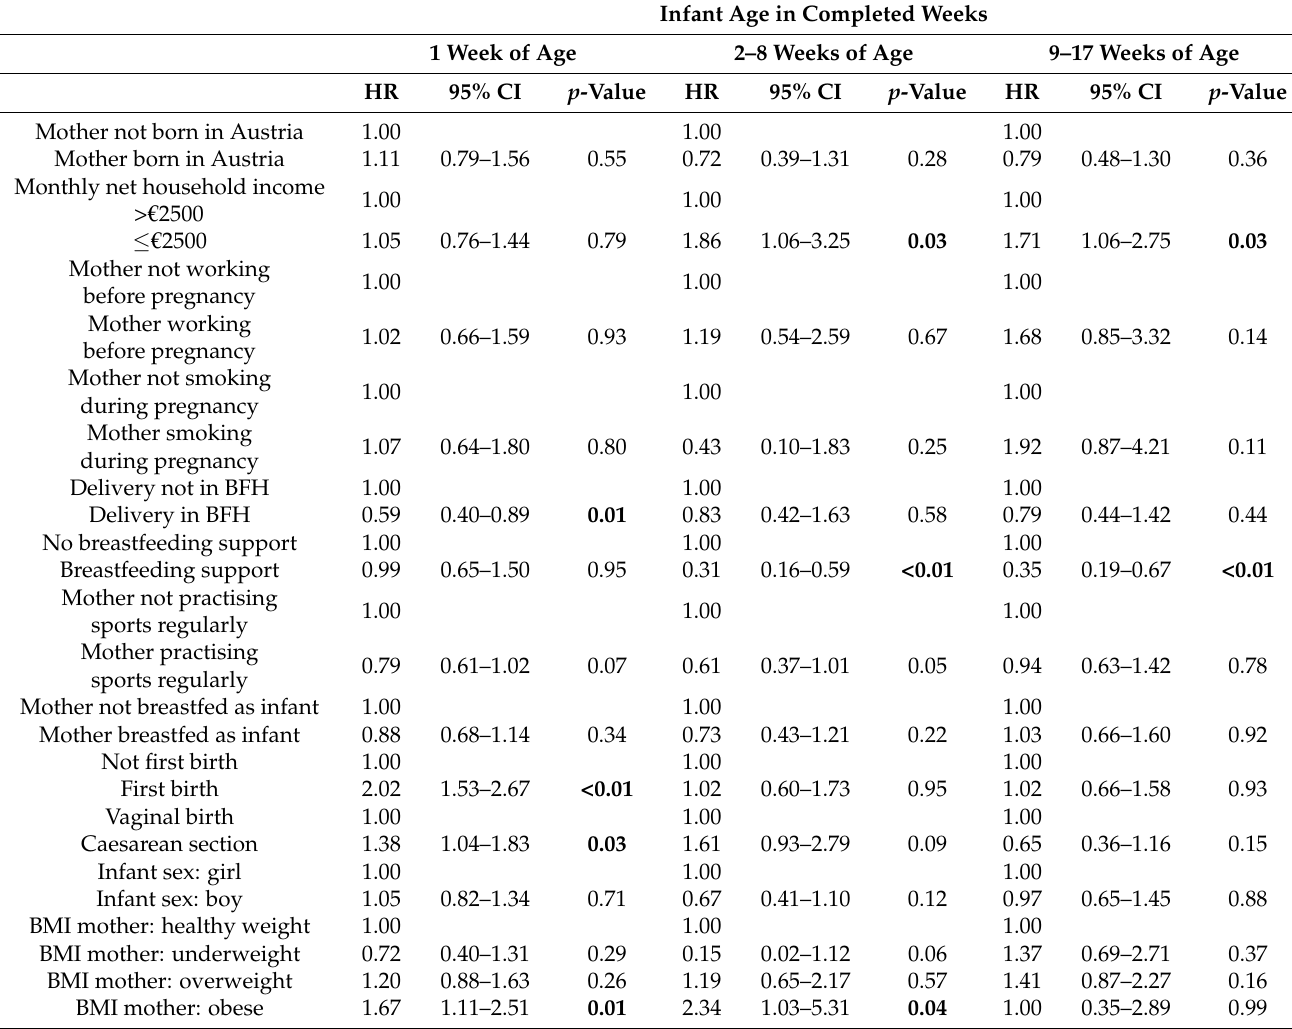
Table 4. Cox- regression of factors influencing exclusively breastfeeding duration considered sepa- rately for 3 different age ranges of infants ( n =